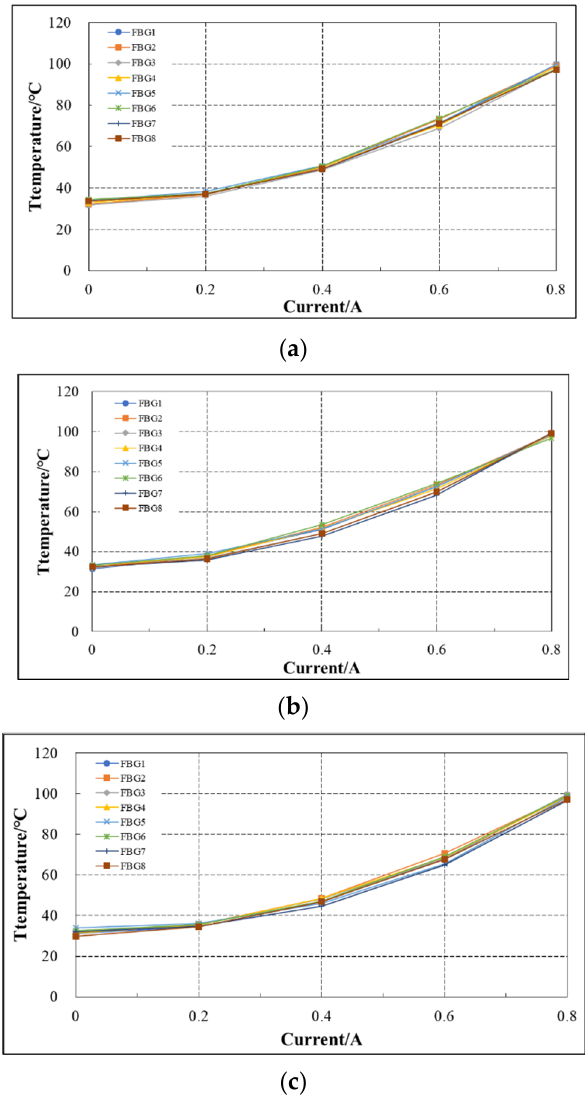
Figure 16. Variation curve of FBG temperature with current. ( a ) Middle and upper part of outer surface of coil. ( b ) Middle and lower part of outer surface of coil. ( c ) Upper part of outer surface of coil.